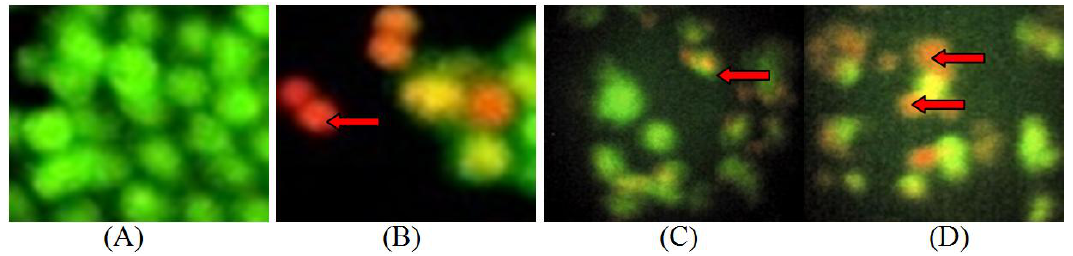
Figure 3. The apoptotic effect of doxorubicin, hesperetin and combination with doxorubicin on MCF-7/DOX cells.